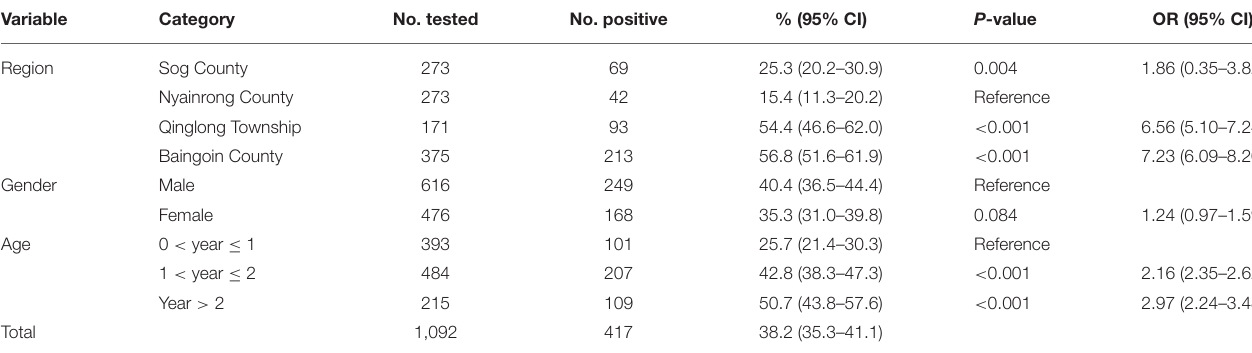
TABLE 2 | Prevalence and risk factors of Echinococcus granulosus infection in Tibetan sheep on Qinghai–Tibet plateau.